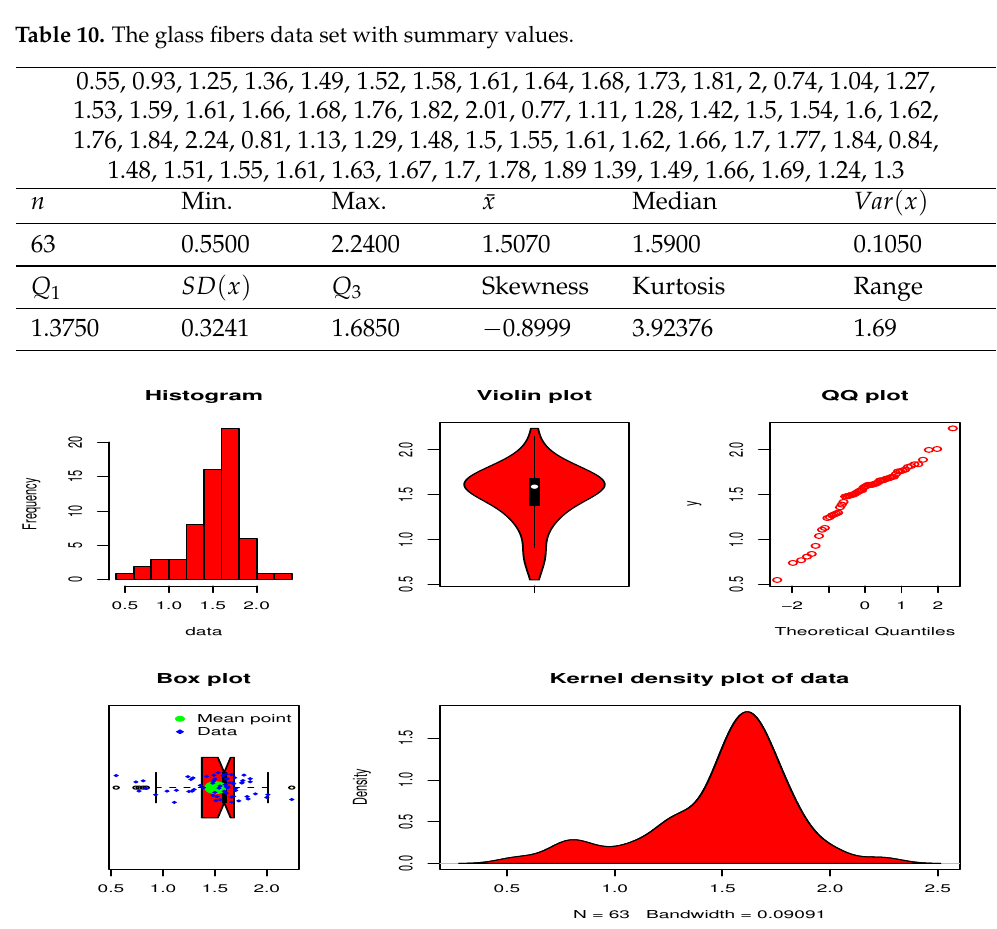
Figure 13. Visual description of the glass fibers data set.